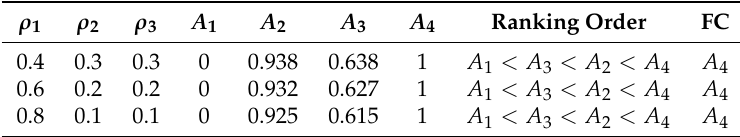
Table 8. Primary risk averter.